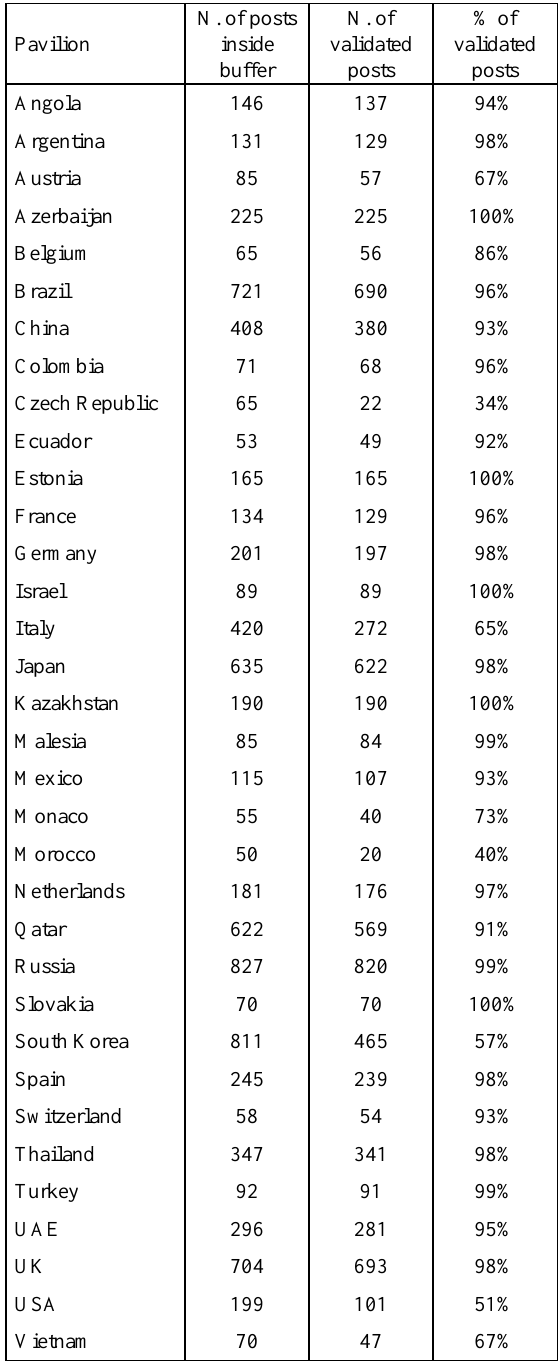
Table 1. Results of the ‘PLACE’ – Buffer validation procedure